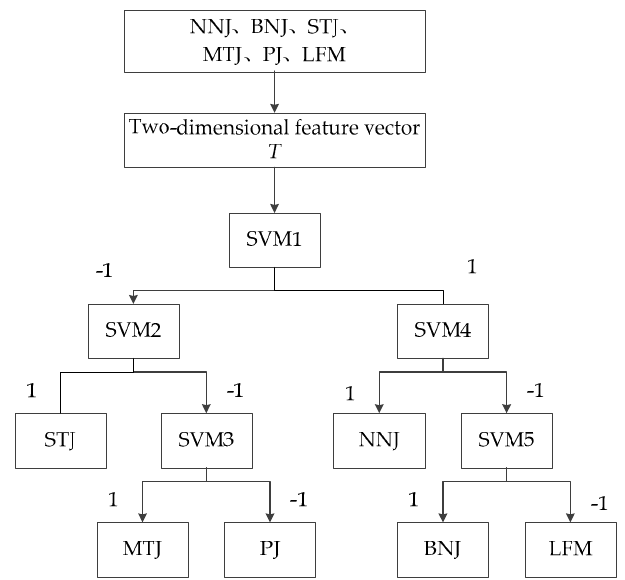
Figure 6. Jamming recognition process based on two-dimensional features.